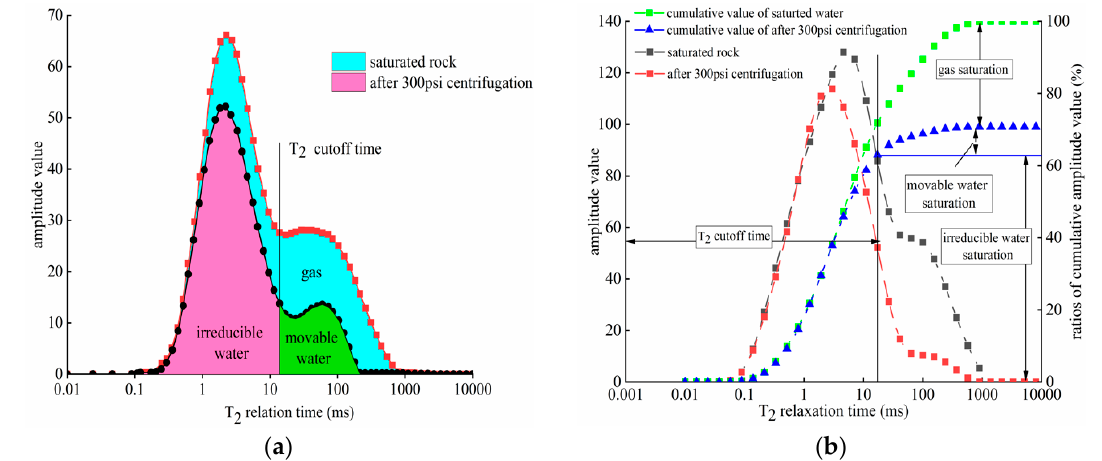
Figure 2. Schematic diagram ( a ) and calculation method ( b ) of movable water saturation.